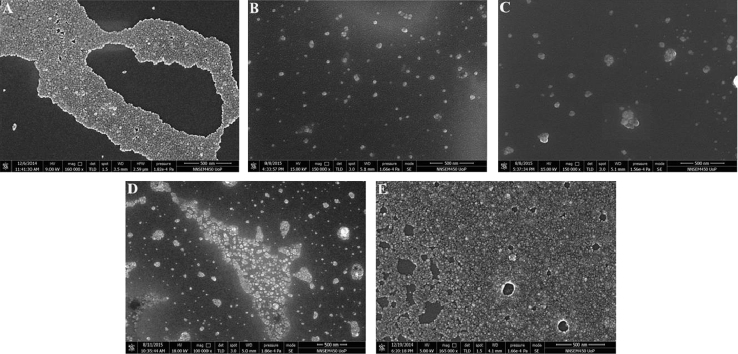
FESEM images recorded on CZTSxSe1−x nanocrystals dispersion dropcasted on silicon wafer, for x=0–1. (A) x=1 (B) x=0.74, (C) x=0.42, (D) x=0.17 and (E) x=0.